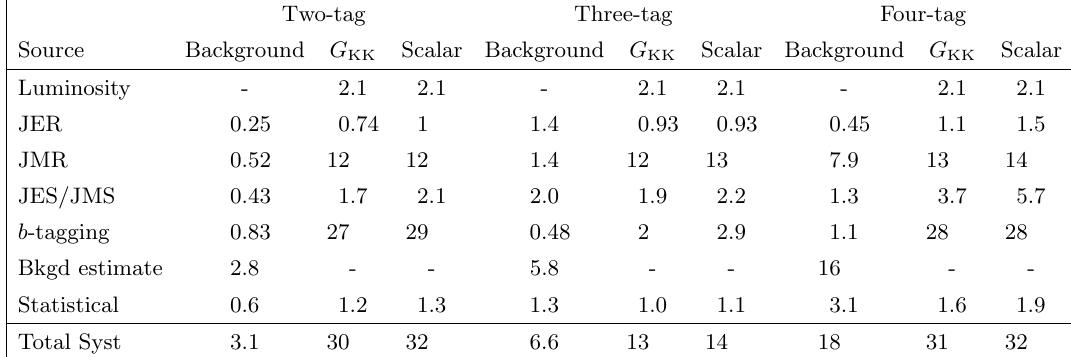
Table 6. Summary of systematic uncertainties (expressed in percentage) in the total background and signal event yields in the signal region of the boosted analysis. Uncertainties are provided for each of the three samples for background, a 2 TeV scalar, and a G KK with k=M Pl = 1 and m = 2 : 0